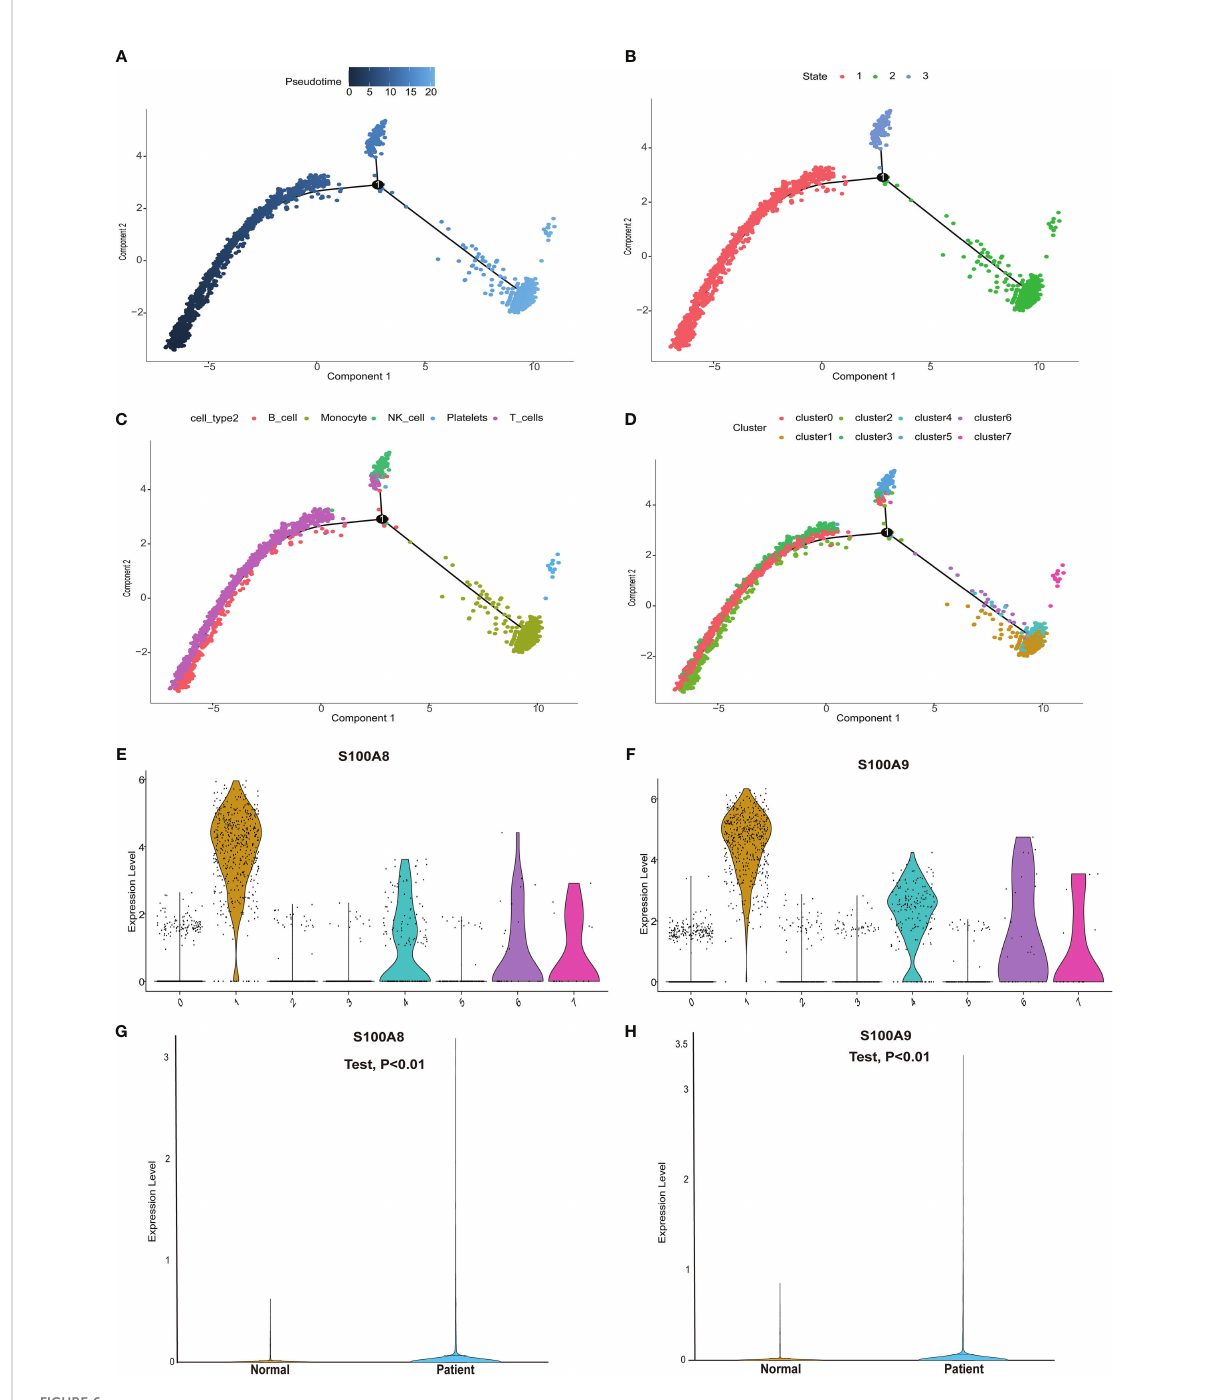
FIGURE 6 Pseudotime analysis and expression level of hub genes in the single-cell dataset. (A) Differences in the time sequence of cell differentiation. Darker blue indicates earlier differentiation, and lighter blue indicates later differentiation. This provided a reference for subsequent analysis. (B) Three differentiation states of calci fi ed valve diseases. The differentiation in state 2 occurred at the latest timepoint. (C) Differences in differentiation among fi ve different cell types. (D) All cells were clustered into eight clusters. (E, F) Analysis of hub gene ( S100A8 / S100A9 ) expression based on our single-cell sequencing dataset from our center. S100A8 / S100A9 expression was upregulated in cluster groups (1, 4, 6, 7), which suggested that hub gene expression is higher in the latest stage of calci fi c aortic valve disease (CAVD). (G, H) S100A8 / S100A9 expression analysis in the single-cell dataset. S100A8 / S100A9 expression was upregulated in